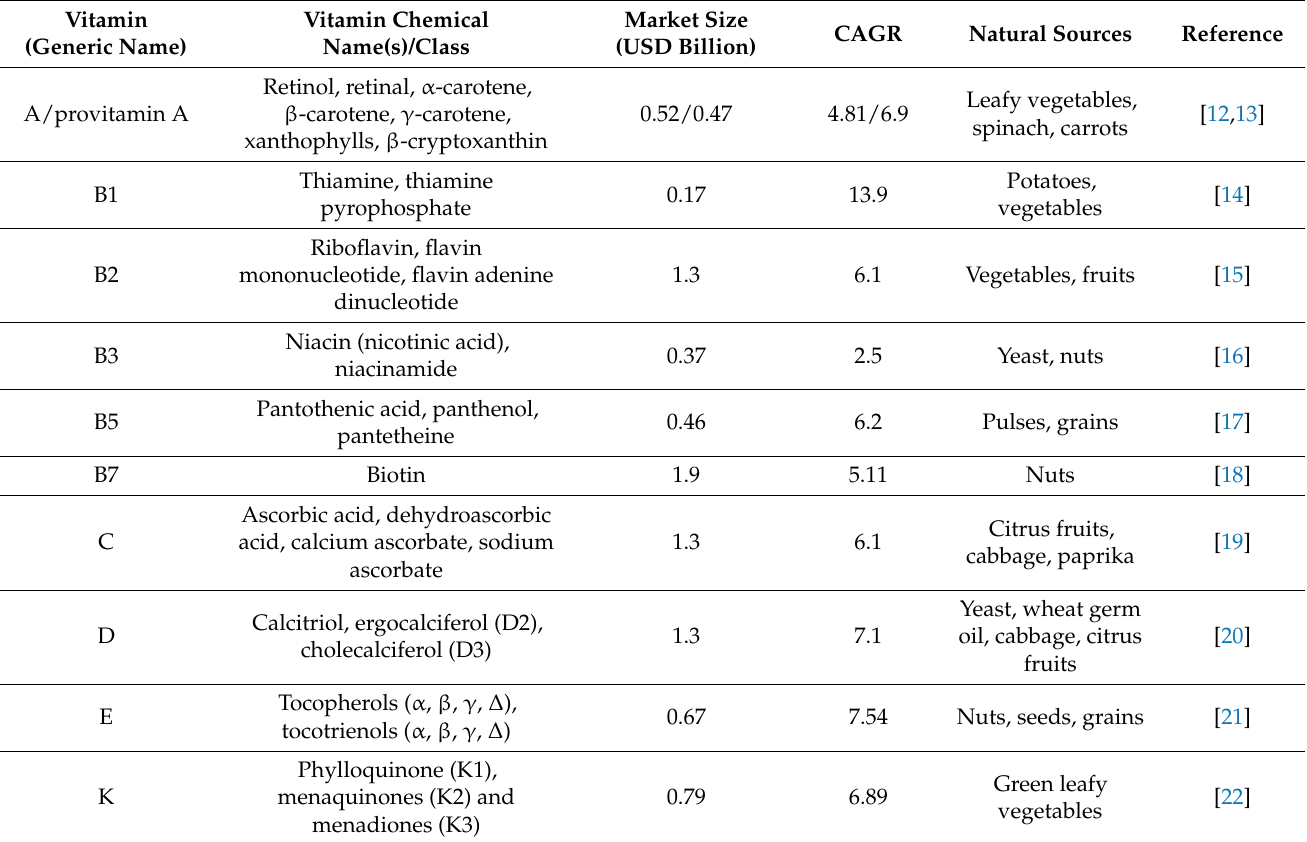
Table 1. Vitamin generic and chemical names, market size and compounded annual growth rate (CAGR), and natural